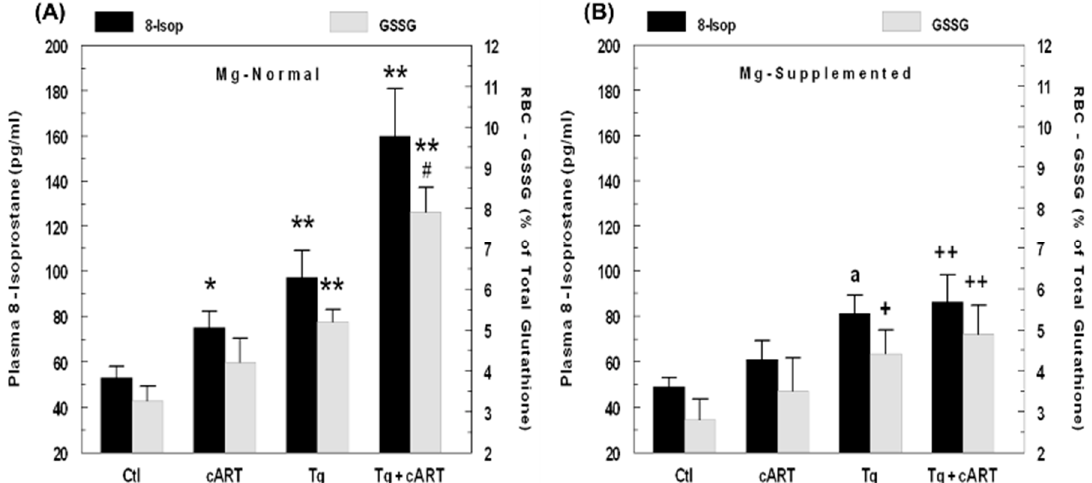
Figure 1. HIV-1 expression and cART –mediated elevations in: Plasma 8-isoprostane and RBC GSSG levels in 6-week normal Mg rats ( A ); and attenuation by Mg supplemented (6-fold higher) diet ( B ). Values are means ± SE = 5 rats/group. * p < 0.05 and ** p < 0.01 vs. respective Ctl. # p < 0.05 vs. Tg alone; a p = 0.055 vs. Mg-normal Tg alone; + p < 0.05 and ++ p < 0.01 vs. Mg-normal counterparts in panel A.